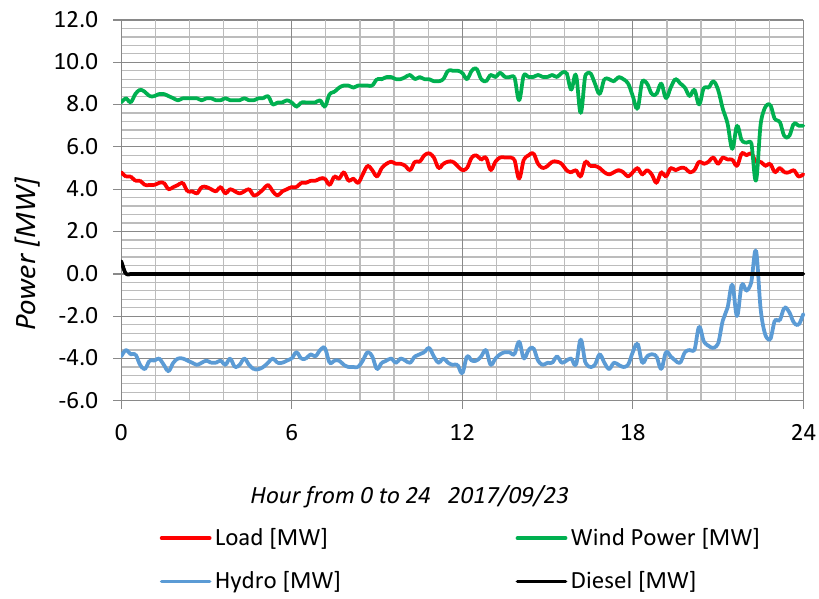
Figure 4. El Hierro power system, demand, wind power and hydropower during September 23rd 2017 (www.ree.es).